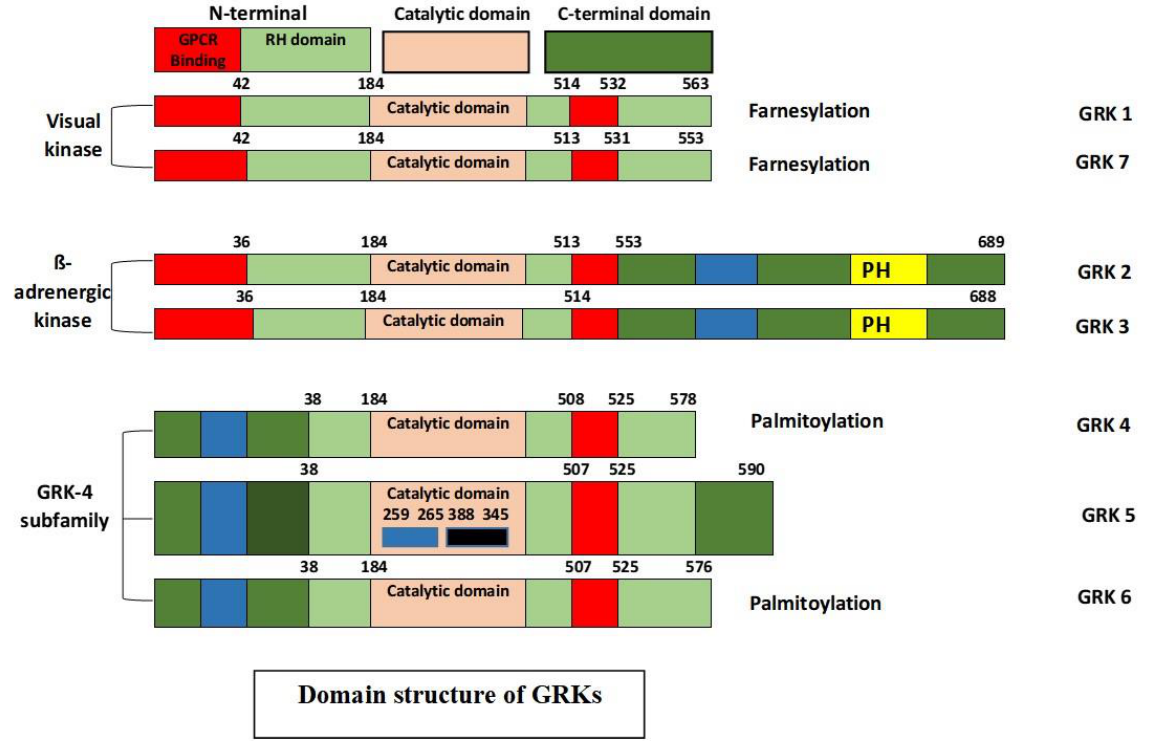
Figure 2. Structural domain distribution of the GRK isoforms. All GRKs (60–80 KDa) have a short N-terminal domain consisting of an α-N-terminal domain followed by an N-terminal regulator of G-protein signaling domain (RH: RGS homology) where the G protein-coupled receptor (GPCR) binds. A central catalytic domain for GRKs catalysis and a unique variable-length C-terminal domain (~105 to 230 amino acids) are important for receptor recognition. In contrast to other isoforms, the β-adrenergic kinase (GRK2 and GRK3) has a pleckstrin homology domain (PH) necessary for terminating Gβγ complex-related downstream signaling. The numbers above the domains represent amino acid residue as reported by Lodowski et al. [21].